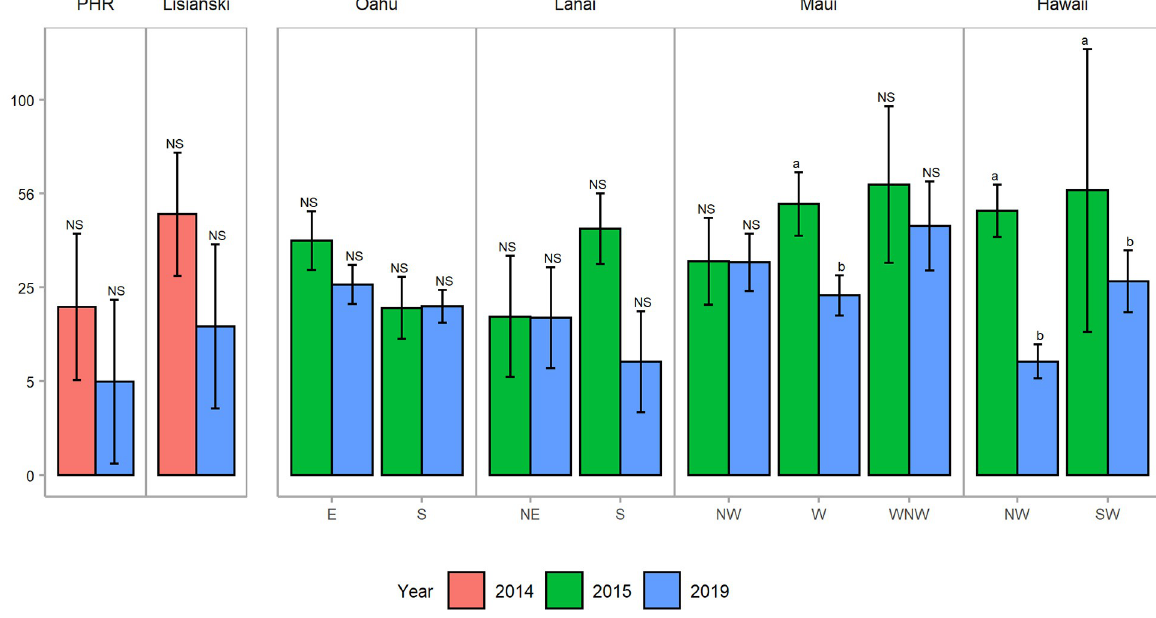
Fig 5. Predicted ( ± 95% CI) percent bleached per island and zone for all depths combined by year. Zones are abbreviated in grey along the x-axis. Islands or zones not connected by the same letter across years are significantly different at p < 0.05 based on Tukey post-hoc tests; ‘NS’ denotes non- significant